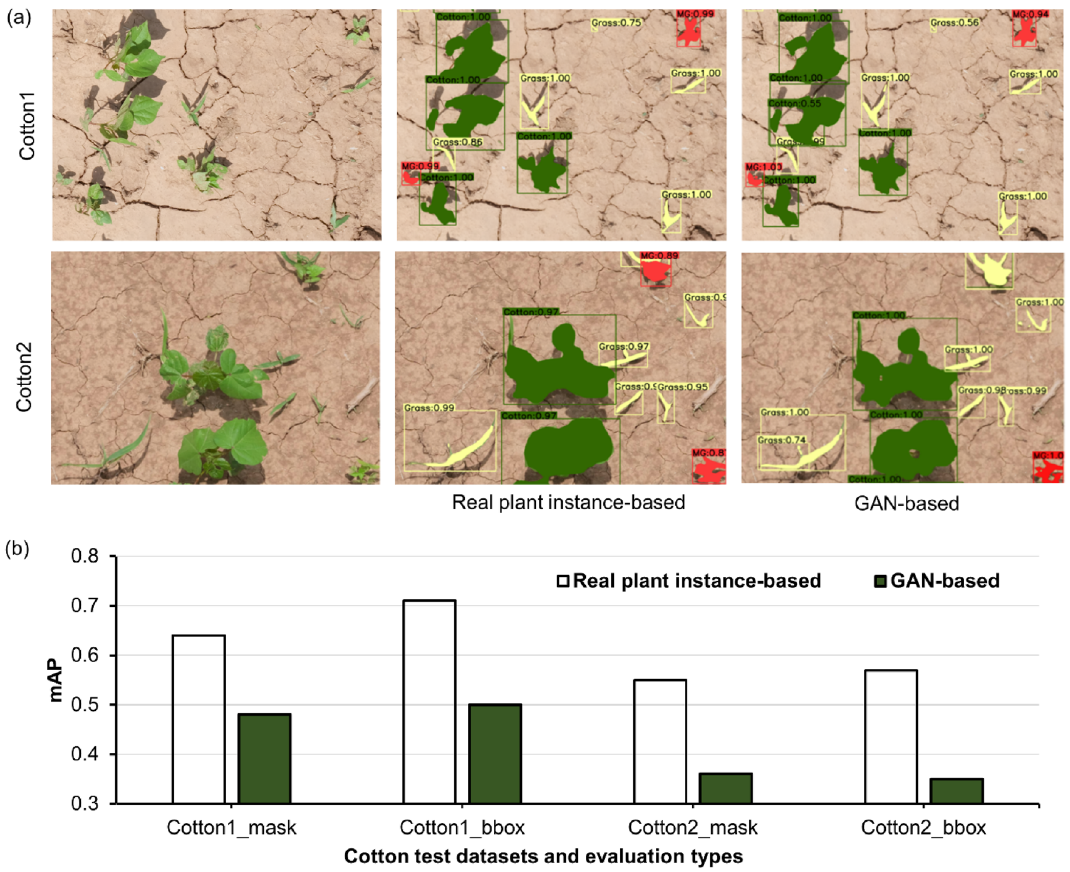
Figure 9. Results obtained from models trained with synthetic images generated using real plant instances and generative adversarial network (GAN)-derived fake plants: ( a ) Detection and segmentation results obtained for the test datasets Cotton1 and Cotton2, and ( b ) Mean average precision (mAP) values for bounding box (bbox) and mask results obtained for Cotton1 and Cotton2. Here, green, red, and yellow detected masks represent cotton, morningglories, and grass,